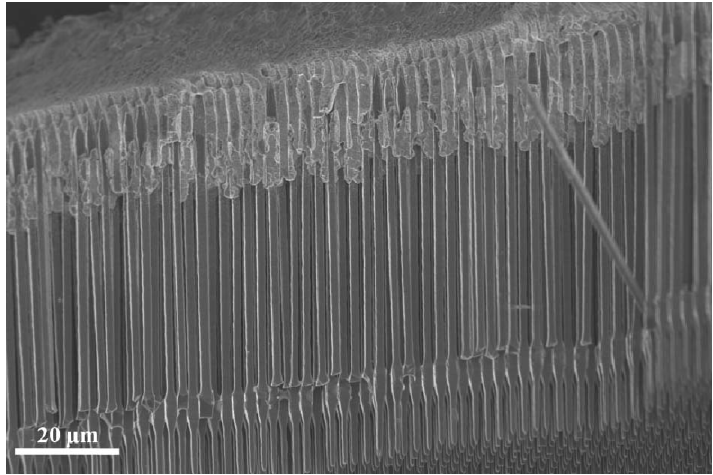
Figure 1. SEM micrograph of the Si microwire anode. The wires are embedded in a Cu layer on their upper